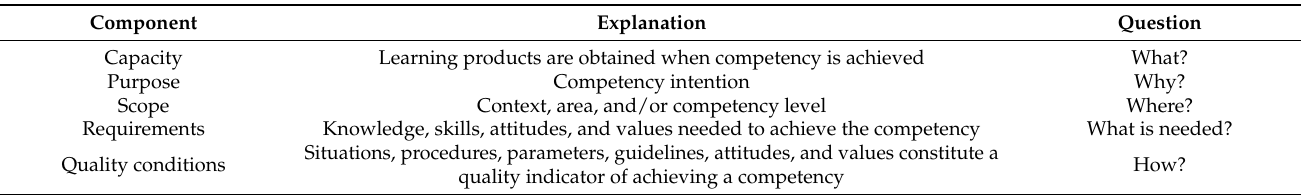
Table 1. Competencies’ components 1